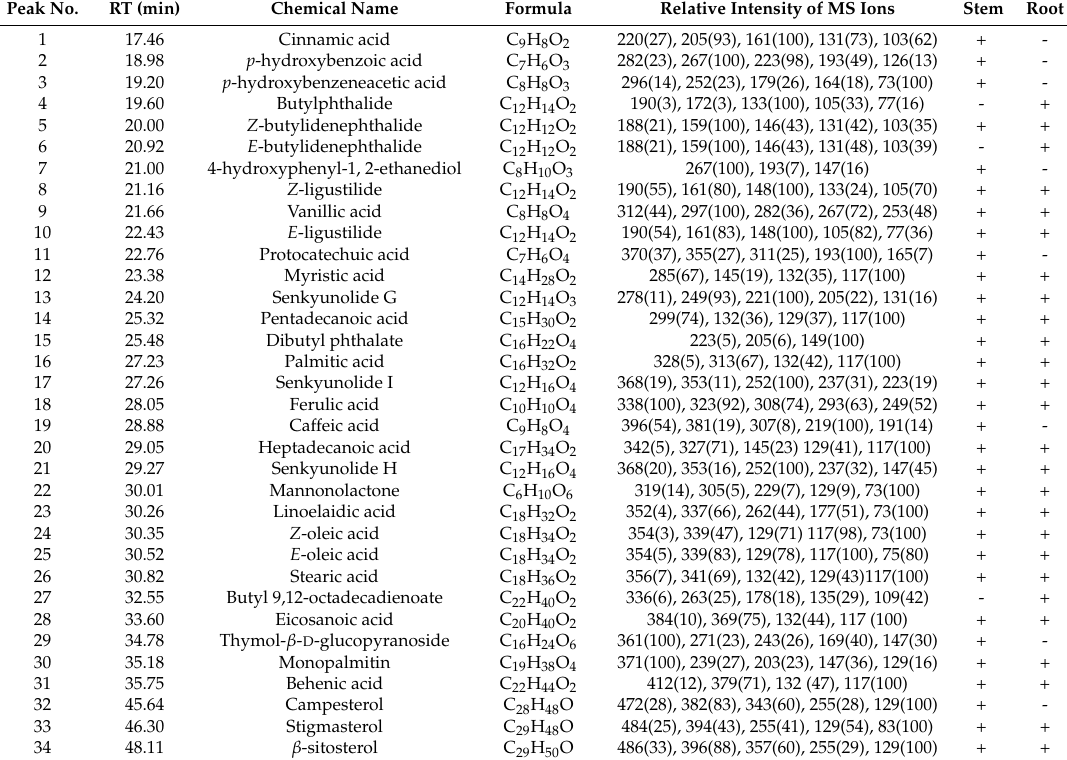
Table 1. Constituent identification from GC chromatograms of AS stem and root extracts. Peak